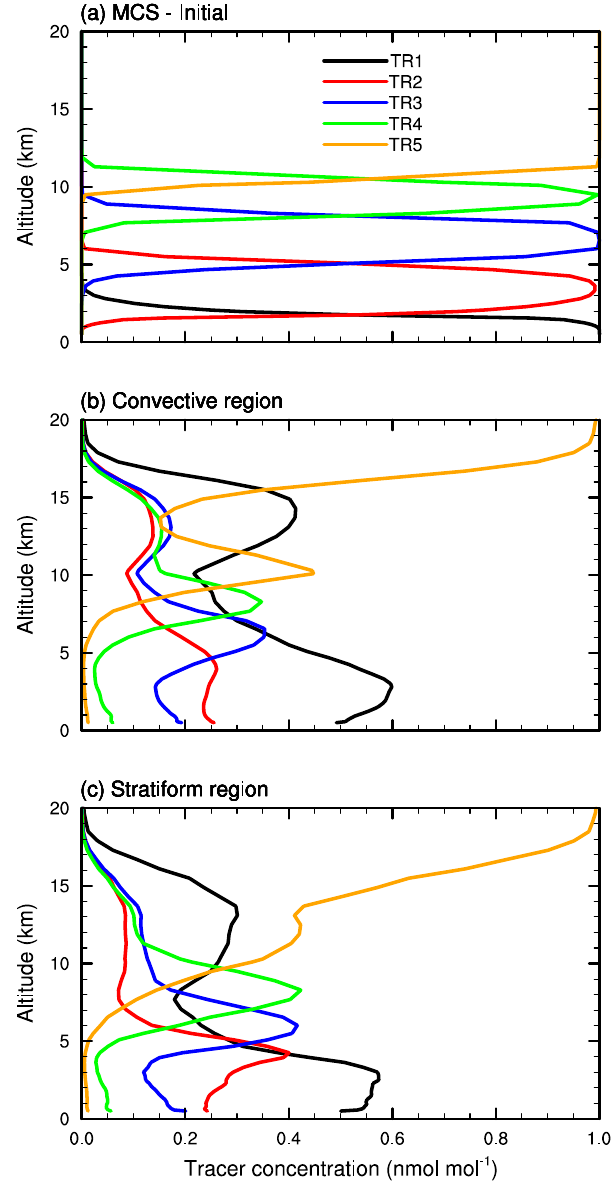
Fig. 9. Tracers concentrations (nmolmol − 1 ) vertical profiles on 15 August 2004 at 02:00UTC before the MCS triggering (a) and at 19:00UTC in the convective (b) and stratiform (c) regions. In (a) , the concentrations are averaged over the sub-domain (16.6–19.0 ◦ N; 6.4–9.0 ◦ E). The convective and stratiform regions are defined as areas with instantaneous precipitation rate higher and lower than 5mmh − 1 ,